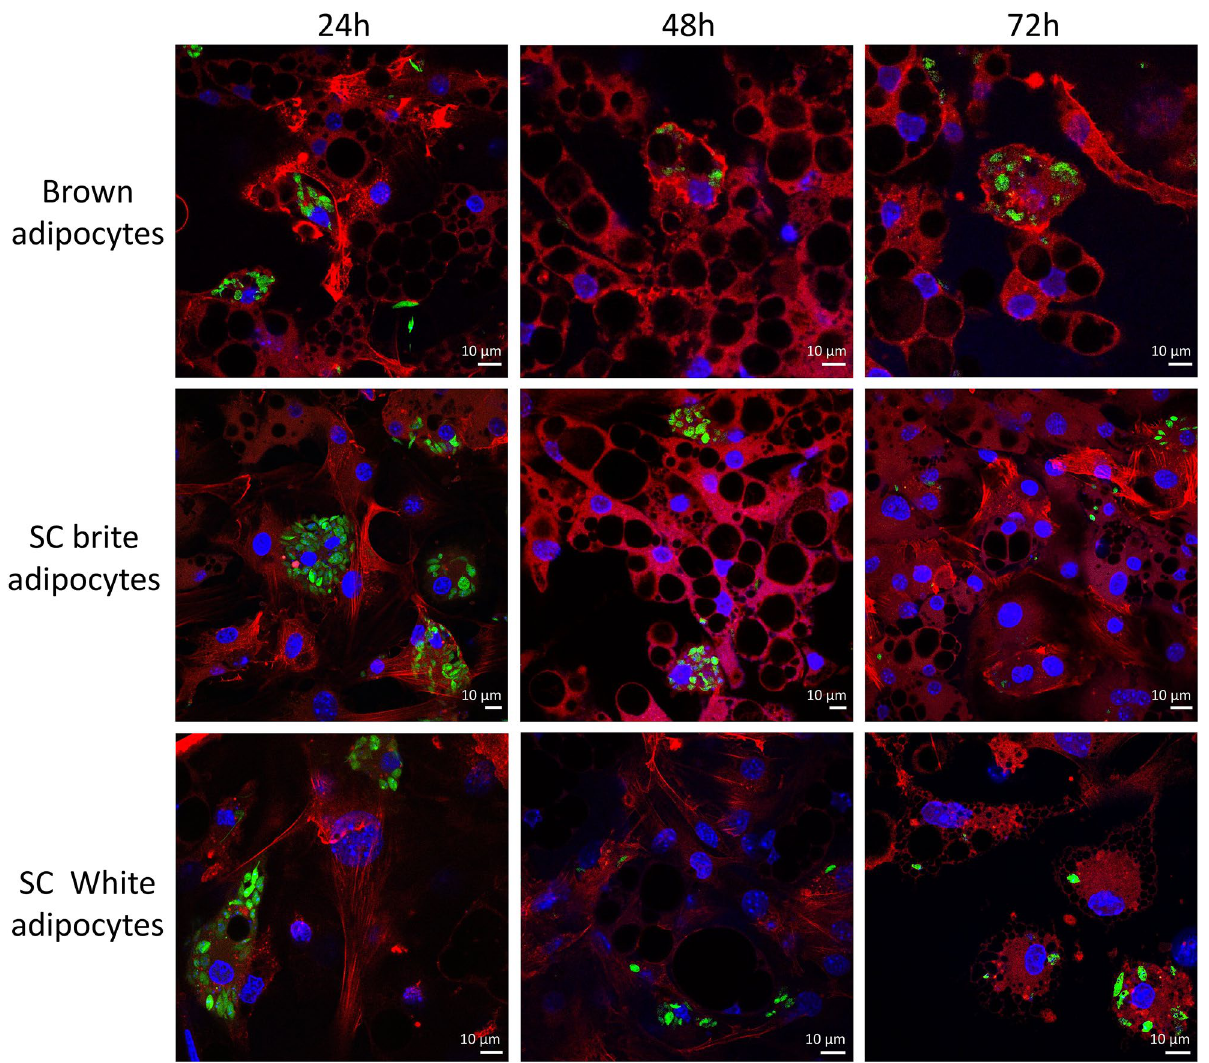
Figure 4. Confocal microscopy of BALB/C adipocytes infected In vitro with GFP- L. infantum . Adipocytes of pre-adipocyte murine origin were infected after 7 days of differentiation with 10 GFP- Leishmania /cells. Red: phallloidin-Txred, Blue: Dapi, Green: GFP-leish. Images were acquired with Nikon Confocal A1R software (NIS-Elements Confocal) from Nikon (https:// www. micro scope. healt hcare. nikon. com). Images were merged with ImageJ bundled with Java 1.8.0_172 (https:// imagej. nih. gov/ ij/). Images were assembled with Adobe Photoshop 2020 (https:// www. adobe.